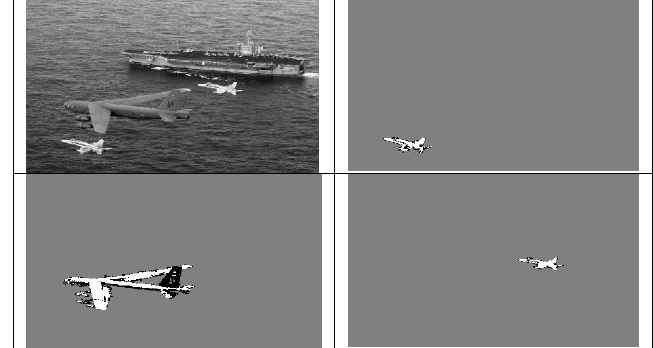
Figure 2. Examples of image